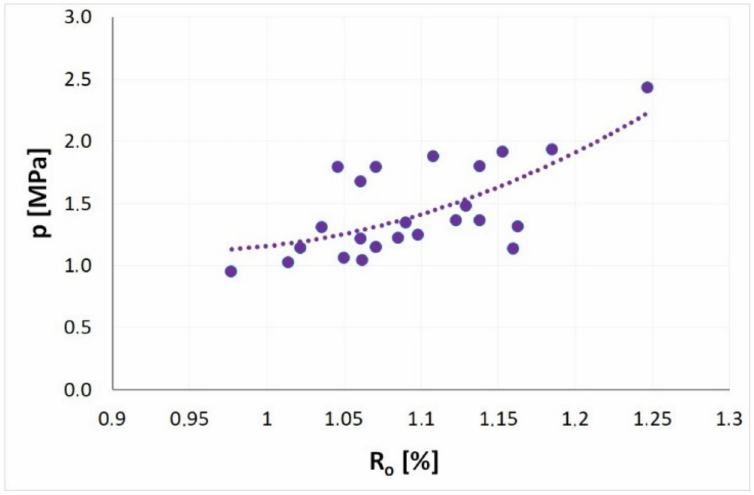
Figure 8. Impact of coalification degree on the seam methane pressure ( Mn = 8 m 3 CH 4 /Mg, 35 ◦ C). Increasing coal seam methane pressure is always an undesirable factor, as it indicates an increased risk of outburst. Even though literature data does not specify a